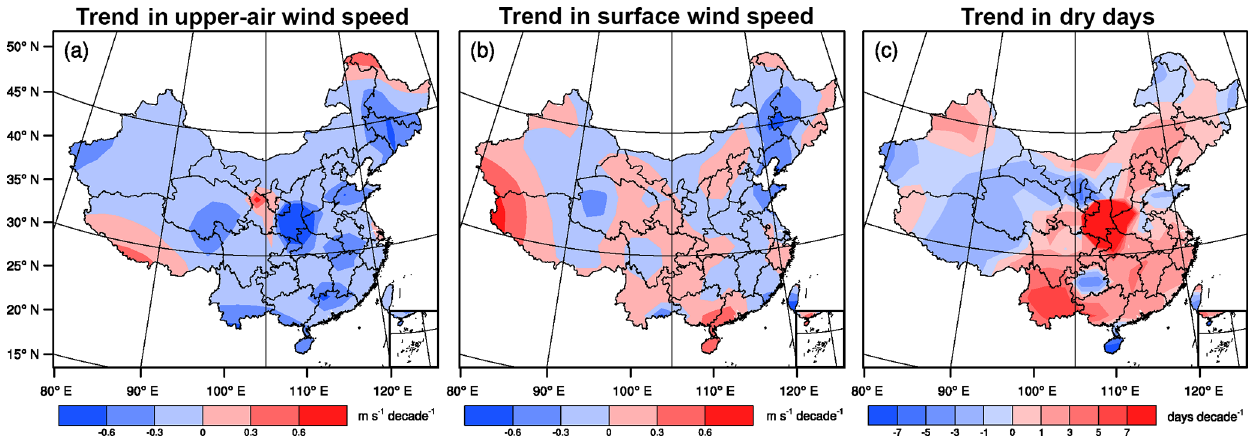
Figure 9. Trends in upper-air wind speed (a) , surface wind speed (b) , and dry days (c) during 1985–2014.